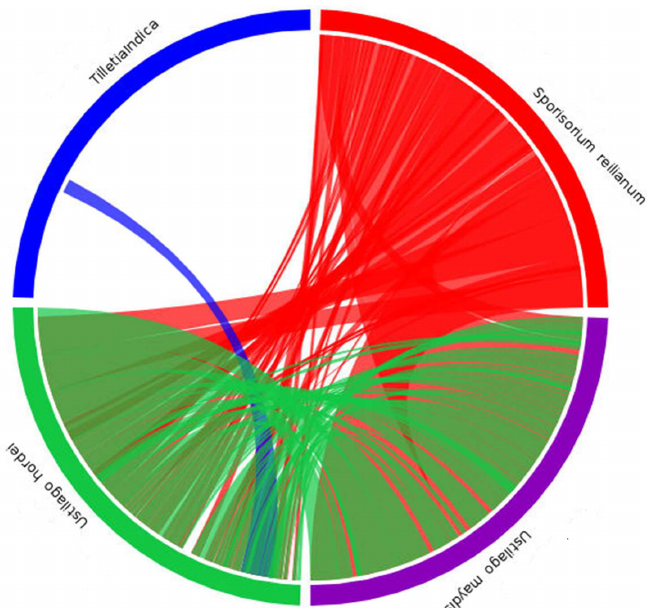
Fig 5. Synteny analysis of T . indica genome with other smut fungi, U . maydis , U . hordei and S . reilianum